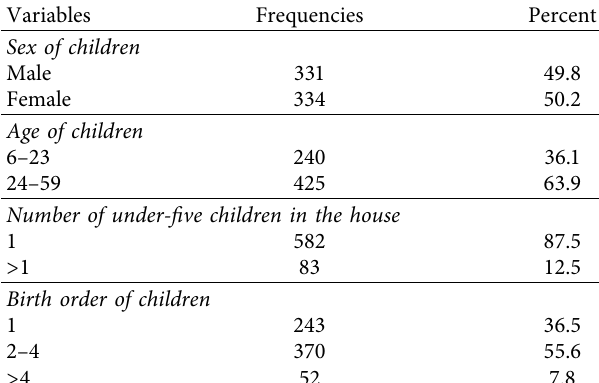
Table 2: Demographic characteristics of children in 2019.